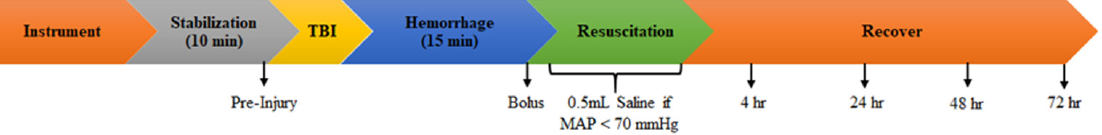
Figure 1. Injury timeline. Instrumentation was followed by 10 min of stabilization, at the end of which pre-injury vitals were recorded. TBI was completed, followed by the 35% volume-controlled hemorrhage. Resuscitation began with 1 mL of T-101 or the control (saline) resuscitative fluid group. If MAP remained below 70 mmHg for 5 min after 1 mL of resuscitative saline or T-101 fluid, then 0.5 mL of saline was infused at 0.1 mL/min. Then, cannulated vessels were ligated, catheters were removed, and the rat was recovered until endpoints at 4, 24, 48, or 72 h after the start of hemorrhage.